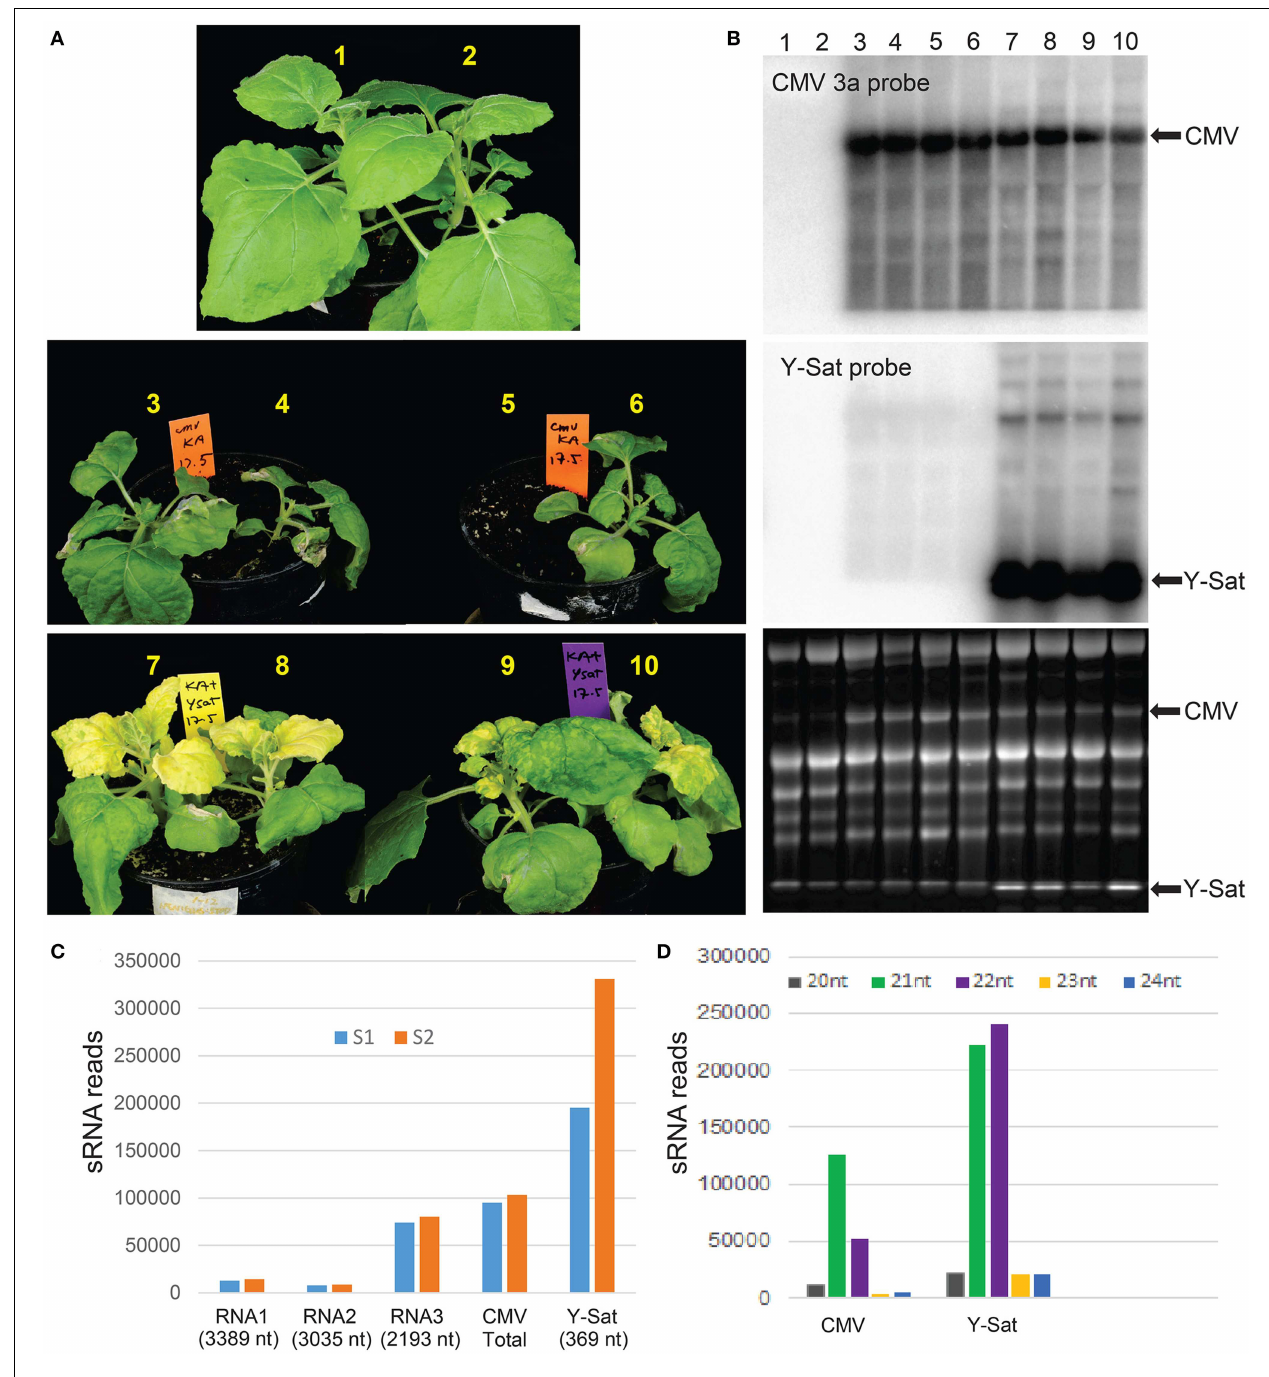
FIGURE 1 | Y-Sat infection reduces the severity of CMV-caused symptoms and is associated with high abundance of Y-Sat siRNAs. (A) N. benthamiana plants co-infected with both Fny-CMV and Y-Sat (bottom) (12 days post inoculation) are healthier and bigger than those infected with Fny-CMV alone (middle), despite the Y-Sat-specific bright yellowing symptoms. Note that plant #5 was very weak and accidentally uprooted prior to photographing. (B) Northern blot analysis of plants in (A) , showing high amounts of Fny-CMV RNA in both CMV